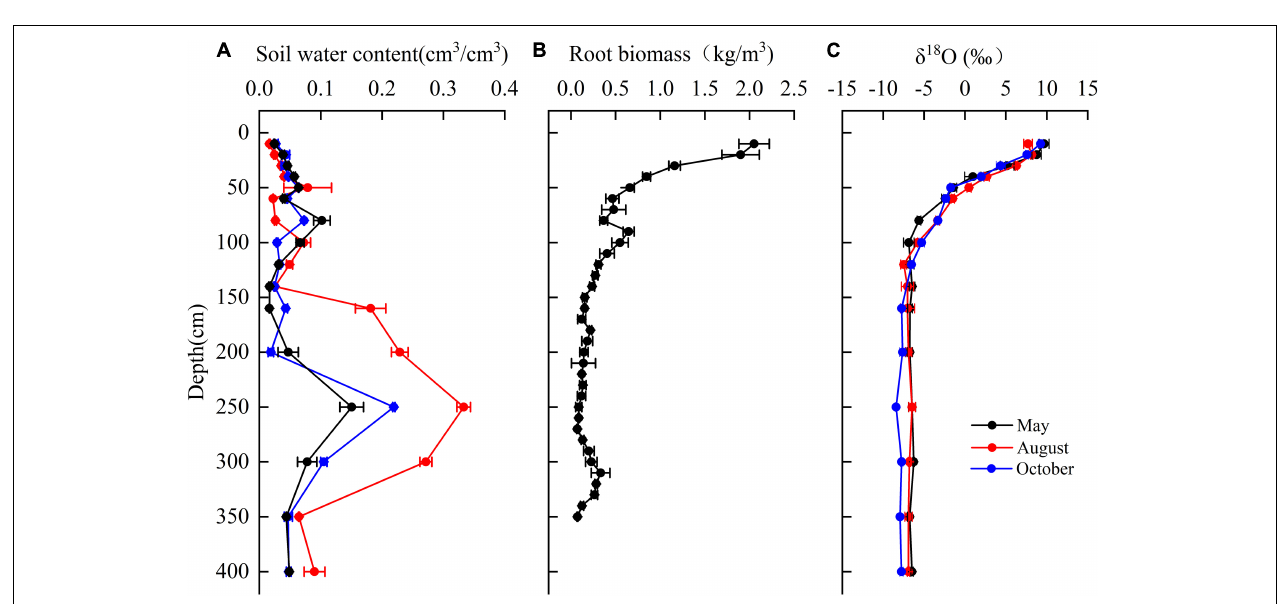
FIGURE 6 | Average relationships between half-hourly averaged SSF and (A) PAR, (B) Ta, and (C) VPD during a day. The arrows indicate the direction of rotation.